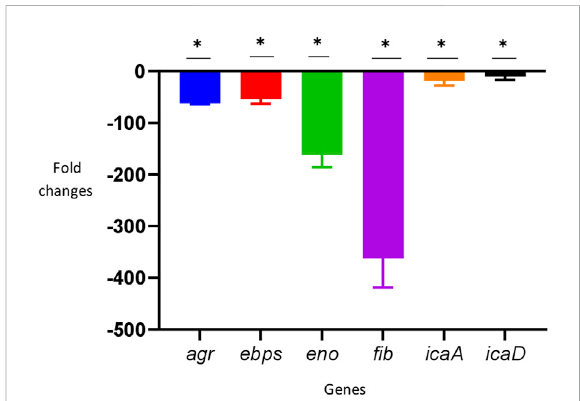
FIGURE 3 Downregulation of bio fi lm-related genes by savirin after 8 h of culture (* = downregulated > 2-fold). The reference gene used was fema and the experiment was performed in triplicate (N = 3). Todeterminetheeffectofsavirin(10 ug/ml)treatmentonthe S. aureus bio fi lm-related genes, comparative C t ( ΔΔ C t ) method was used and the results were expressed as mean fold changes ±